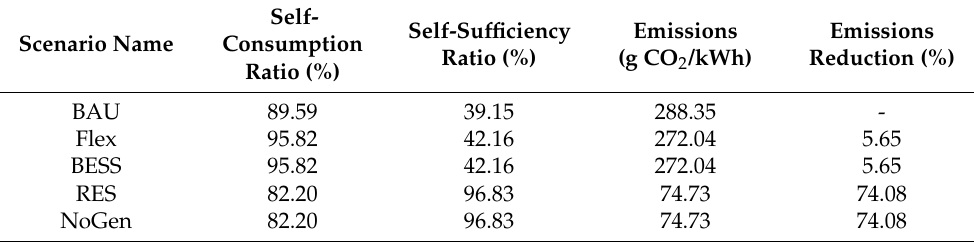
Table 10. Self-consumption ratio, self-sufficiency ratio and CO 2 emission results with lower diesel